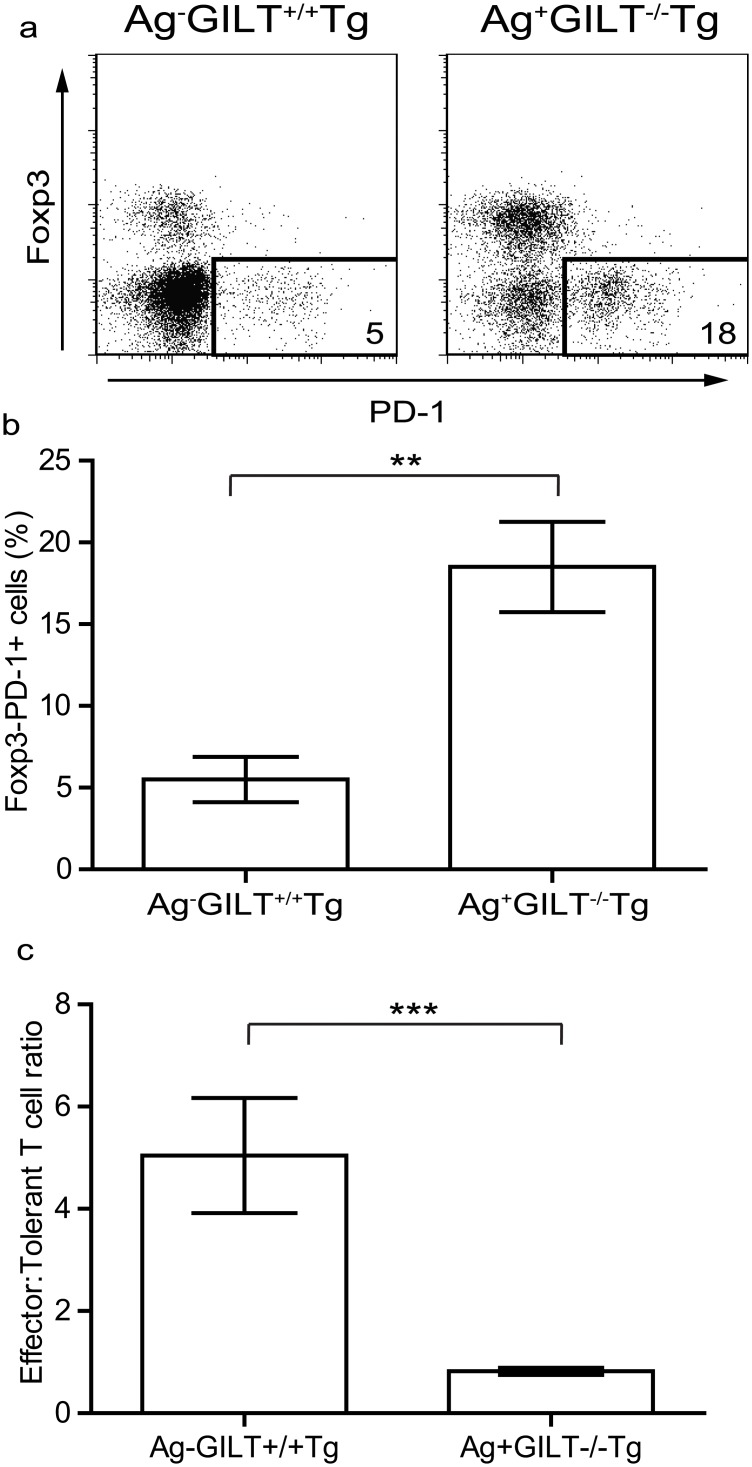
An increased percentage of melanoma-specific T cells from TRP1-expressing mice express PD-1 compared to TRP1-deficient mice.
(a) Skin-draining lymph node cells from Ag+GILT-/-Tg and Ag-GILT+/+Tg mice were stained and analyzed by flow cytometry. Cells were gated on CD4+Vβ14+ TRP1-specific T cells. (b) Percentage of Foxp3-PD-1+ T cells in the CD4+Vβ14+ gate from the skin-draining lymph nodes of Ag-GILT+/+Tg and Ag+GILT-/-Tg mice. (c) Ratio of CD4+Vβ14+ TRP1-specific effector (Foxp3-PD-1-) to tolerant (Foxp3+PD-1- and Foxp3-PD-1+) T cells. Data shown in b and c are from two pooled experiments (total n = 6) and are compared using an unpaired t test (**p<0.01; ***p<0.001).